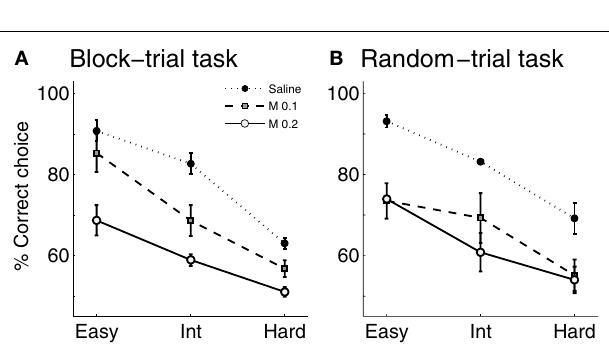
FIGURE 5 | Effect of mPFC inactivation on time interval discrimination. The graphs show the proportion of correct choices at different levels of diffi culty (easy, intermediate and hard) following saline or muscimol infusions (experiment 2). (A) Block-trial task. (B) Random-trial task. Error bars indicate SEM ( n = 3 animals in each task). Int: intermediate level; M 0.1: muscimol 0.1 µg infusions; M 0.2: muscimol 0.2 µg infusions.